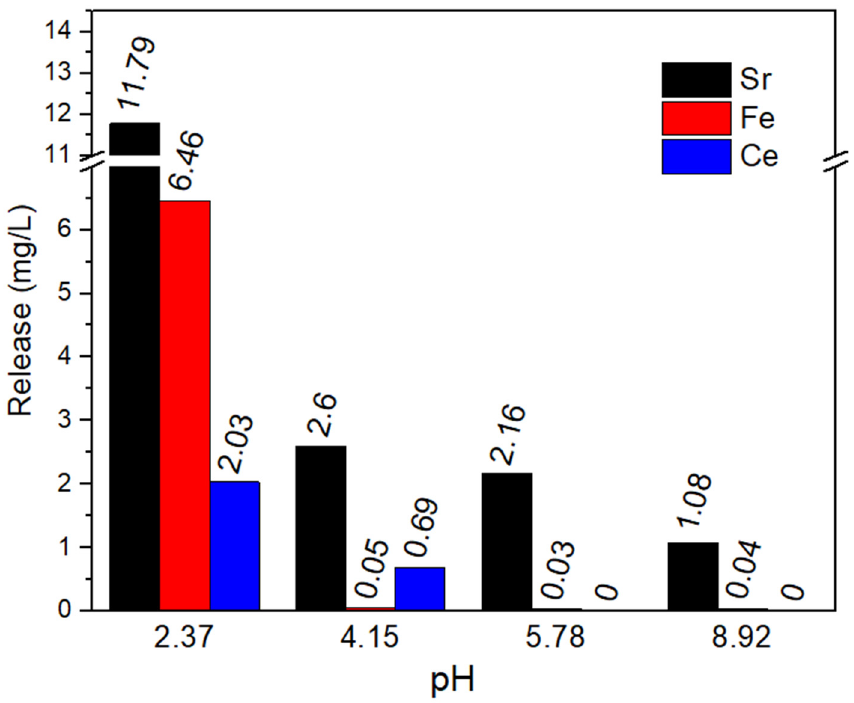
Figure 7. Sr, Fe, and Ce concentrations in solution released from perovskite at different pH values, for the NPW13-1000_A sample.